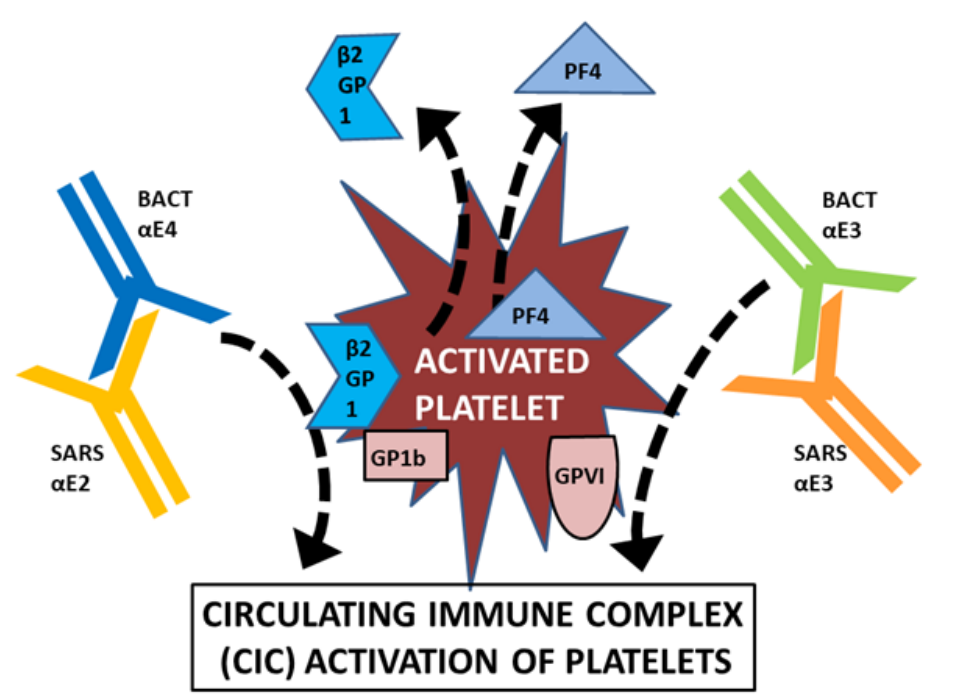
Figure 17. Circulating immune complexes formed from complementary bacterial (BACT) and SARS-CoV-2 virus (SARS) antibody idiotypes, particularly those involving PF4-reactive antibodies, will activate platelets leading to coagulation initiation. GP1b = platelet glycoprotein 1b; GPVI = platelet glycoprotein VI. See Figure 16 for other abbreviations.